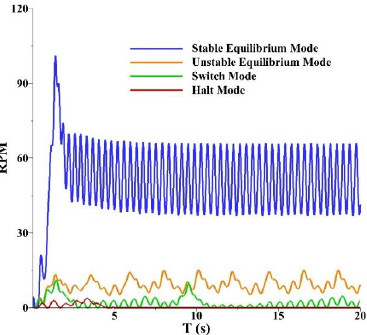
Figure 8. Four typical modes of self-starting processes under the load conditions.